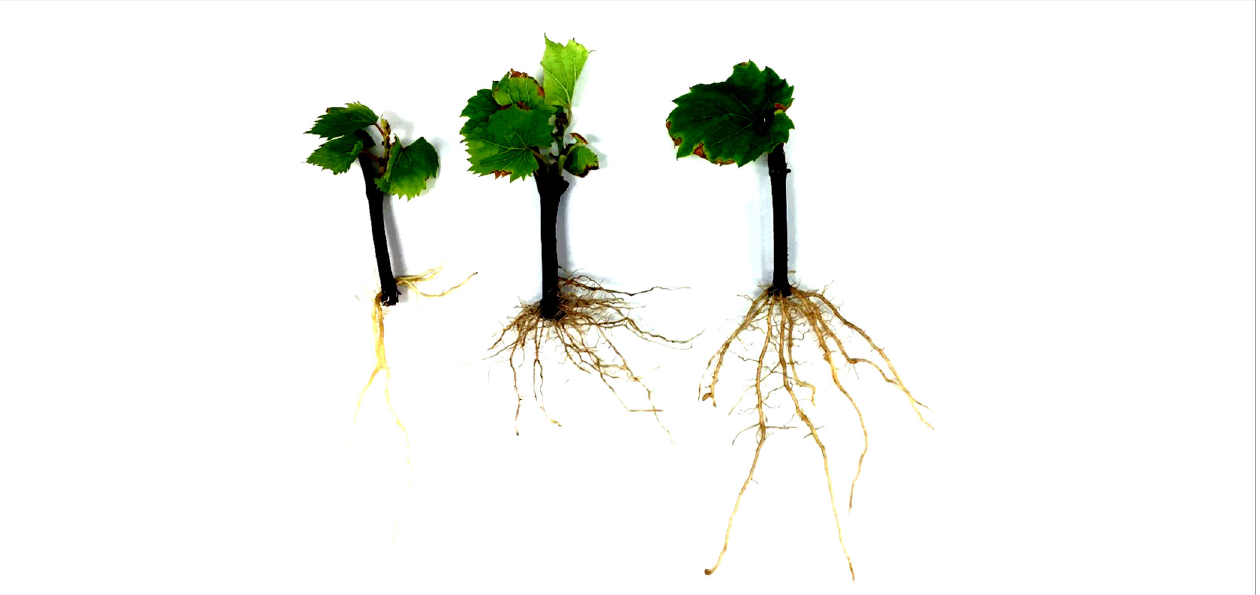
FIGURE 1 Representative adventitious root systems for the grandparents and parent of the VRS-F 2 population. V. riparia ‘ Manitoba 37 ’ (left) and ‘ Seyval blanc ’ (middle), and the VRS-F 2 population parent 16-9-2 (F 1)